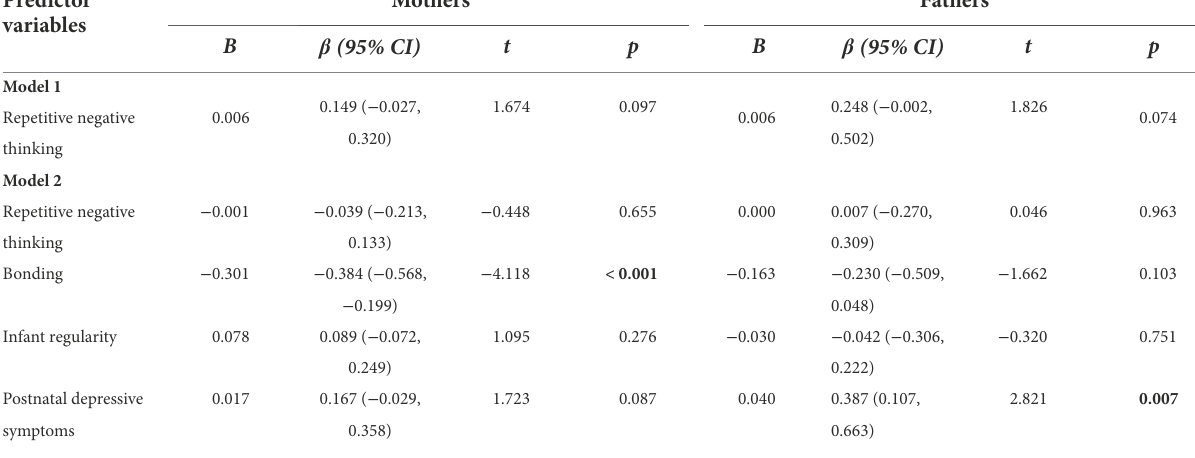
TABLE 5 Results of hierarchical regression predicting parents’ perception of infant temperament (PSI-CD T5.) Predictor